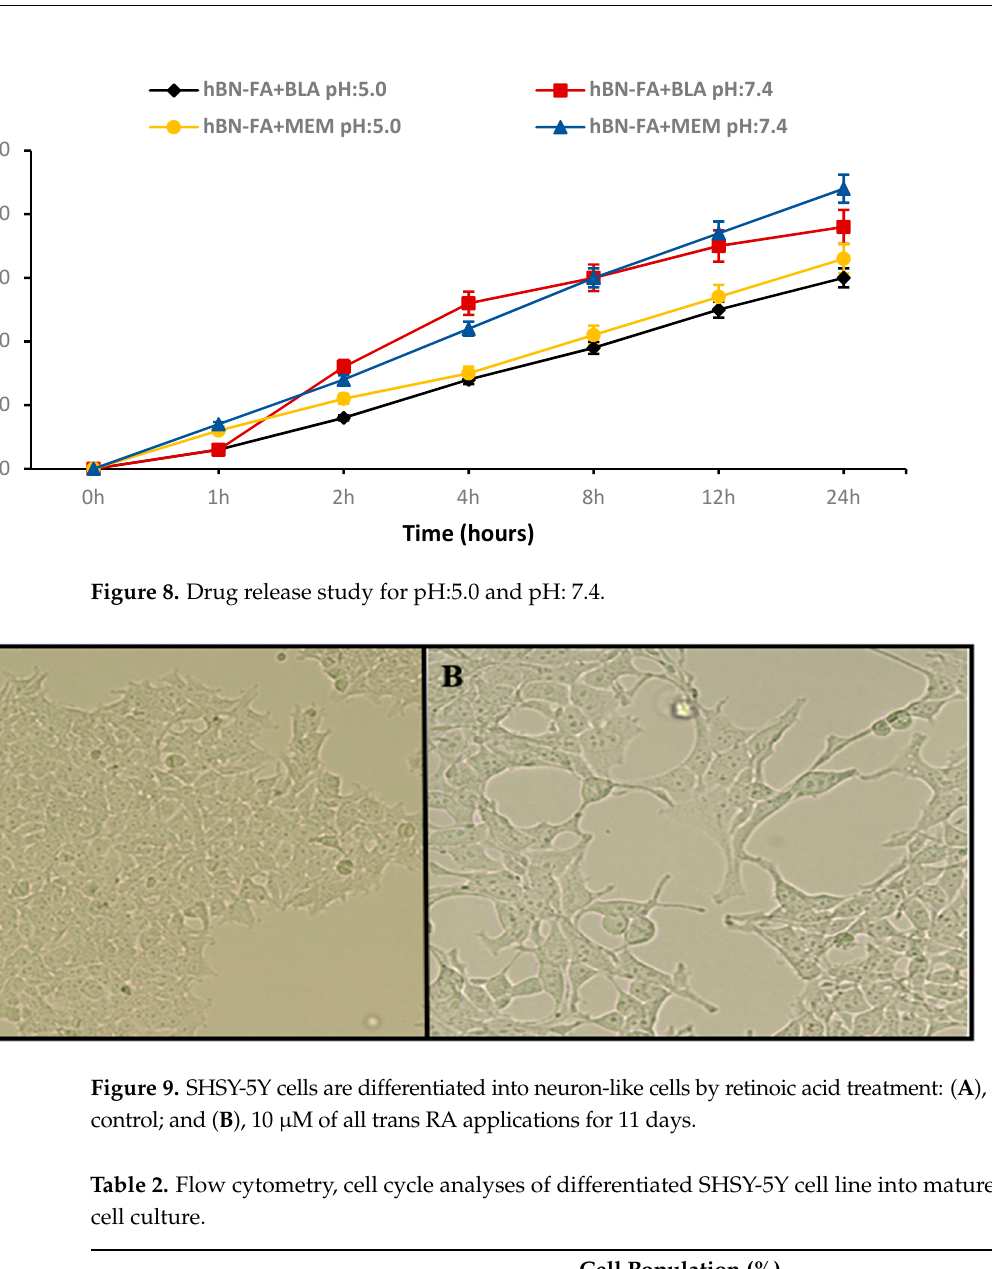
Figure 8. Drug release study for pH:5.0 and pH: 7.4.